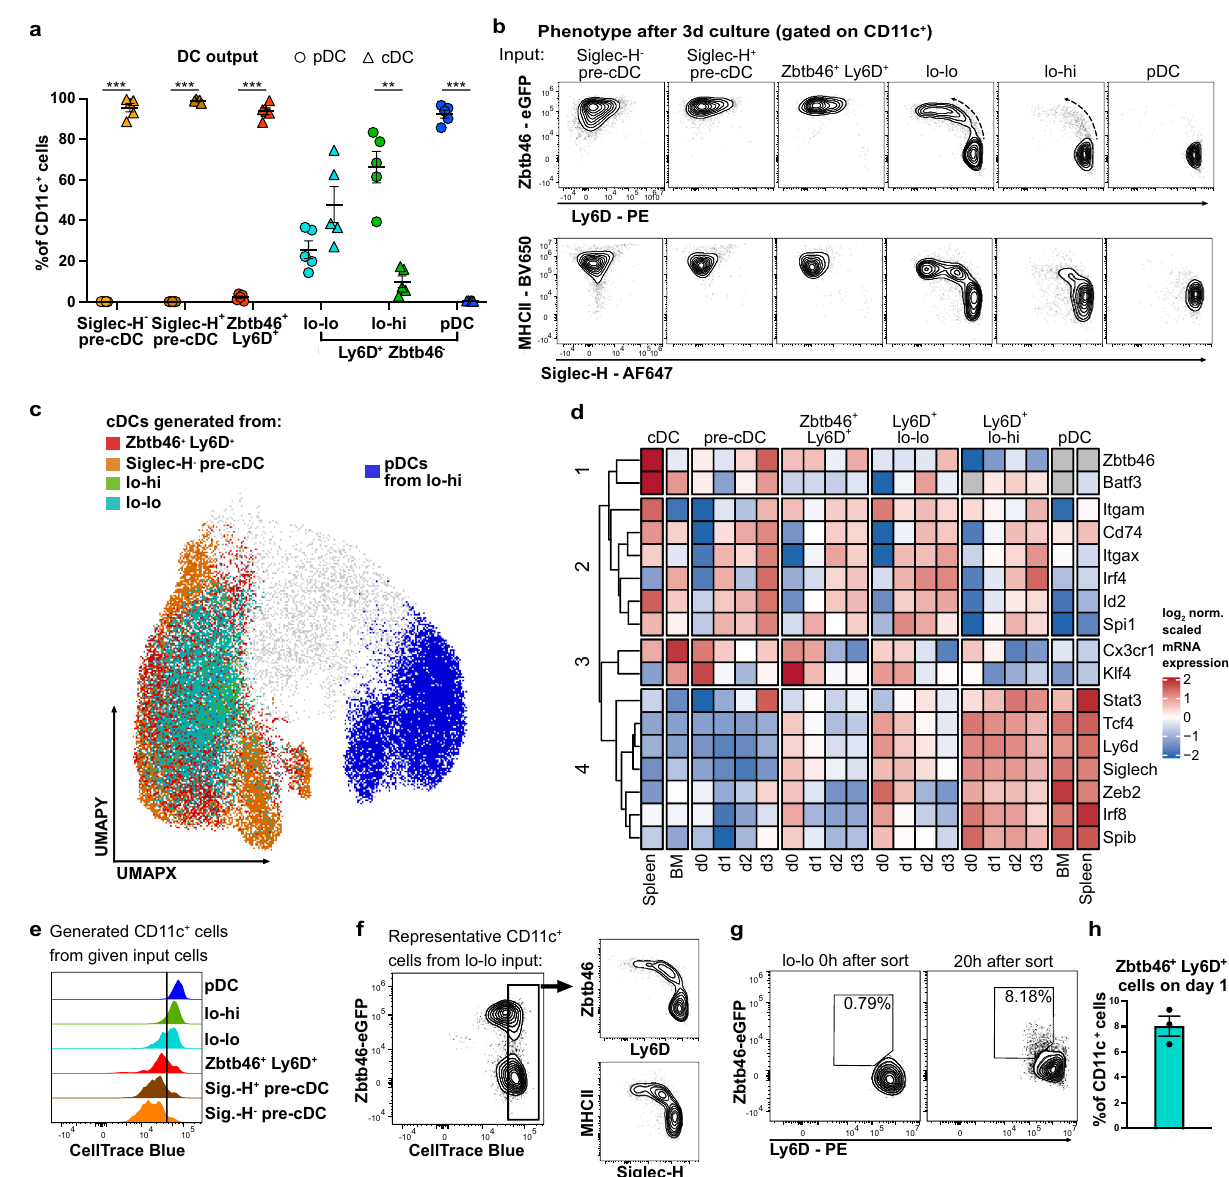
Fig. 4 CD11c + Siglec-H + Ly6D hi Zbtb46 – CCR9 lo B220 lo precursors contribute to cDCs via a Zbtb46 + Ly6D + intermediary stage. a Siglec-H – pre-cDC, Siglec-H + pre-cDC, Siglec-H + Zbtb46 + Ly6D + cells as well as lo-lo, lo-hi precursors and pDCs (gated Siglec-H + Ly6D hi Zbtb46 – as shown in Fig. 3a) were sorted from Lineage-depleted BM cells of heterozygous Zbtb46 gfp mice and cultured for 3 days with Flt3L on EL08-1D2 stromal cells. The phenotype of the progeny was analyzed by fl ow cytometry. Percentages of pDCs (circles) or cDCs (triangles) within CD11c + progeny are shown (mean ± SEM, n = 5); pDC vs cDC output was compared using paired, two-sided t-tests with Holm- Š ídák correction for multiple testing. Adjusted p -values: <0.05(*), <0.005(**), <0.0.001(***). b Phenotype of cells derived from the indicated populations after 3 days of culture (representative results, n = 5). A potential transition from Ly6D + Zbtb46 – to Zbtb46 + Ly6D – is indicated by the dotted arrows. c The indicated populations were sorted and cultured for 3 days with Flt3L without stromal cells, then analyzed by fl ow cytometry. UMAP analysis of concatenated CD11c + cells from all samples. cDCs generated from each precursor subset were gated as CD11c + Zbtb46 high MHCII high and projected onto the UMAP, together with pDCs generated from lo-hi precursors for comparison. d Heatmap of hierarchically clustered log 2 normalized relative gene expression (scaled per gene) in the progeny of the indicated DC precursors before or after 1, 2 and 3 days of culture with Flt3L measured by qRT-PCR (grey: not detectable). Gene expression in freshly isolated BM and spleen pDC and cDC served as a reference (mean values of 2 independent experiments are shown). e CellTrace Blue proliferation dye signal in the CD11c + fraction of the indicated input cells after 3d of culture (representative results, n = 5). f Expression of the indicated markers in the undivided fraction of CD11c + cells generated from lo-lo precursors after 3 days. g Zbtb46 and Ly6D expression in lo-lo precursor cells directly after sorting and after 20 h of culture with Flt3L. The precentage of Zbtb46 + Ly6D + cells is shown in the gates. h Percentage of Zbtb46 + Ly6D + cells within CD11c + cells derived from lo-lo precursors after 20 h of culture (mean ± SEM, n =